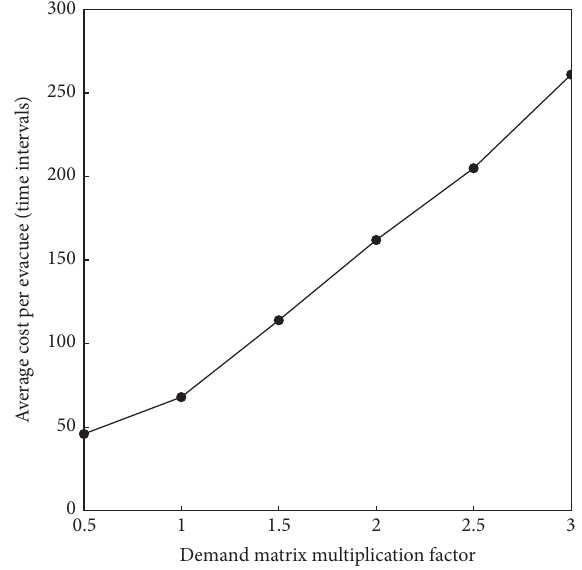
Figure 6: Change of average cost per evacuee with demand matrix multiplication